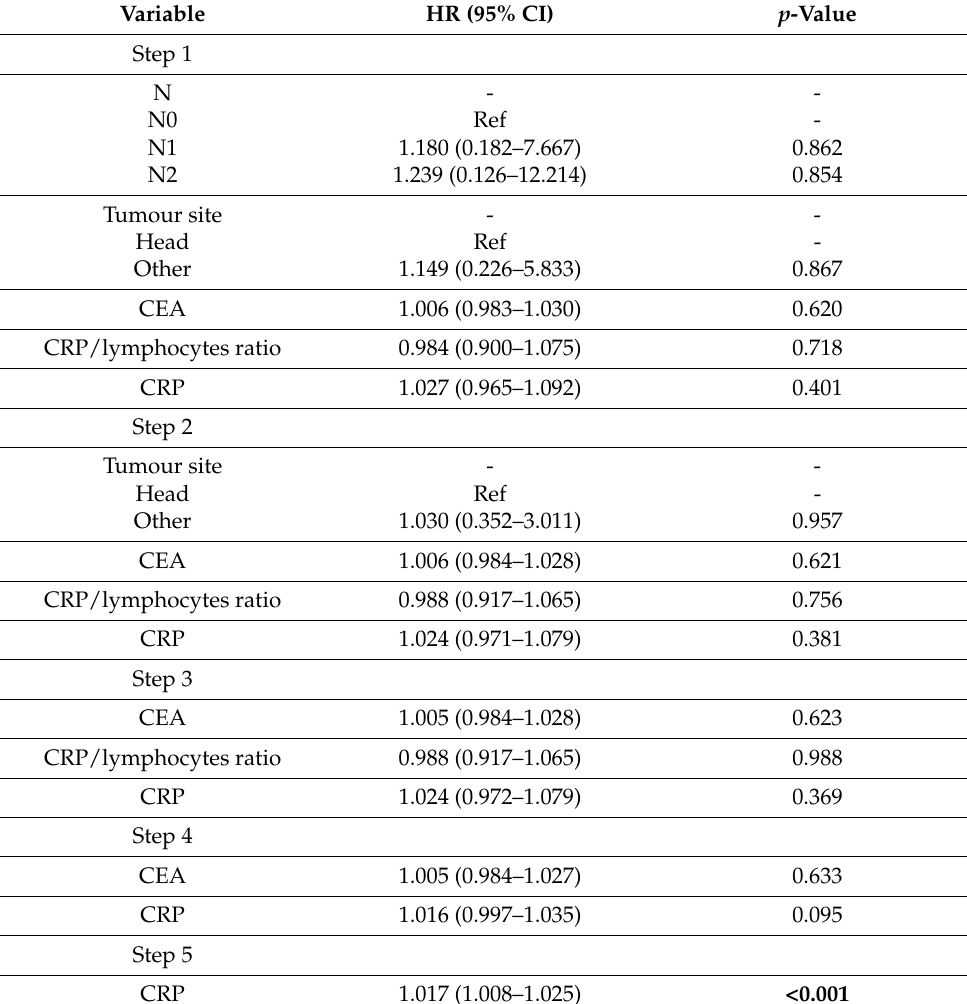
Table 3. Multivariate analysis of prognostic factors for overall survival—DM